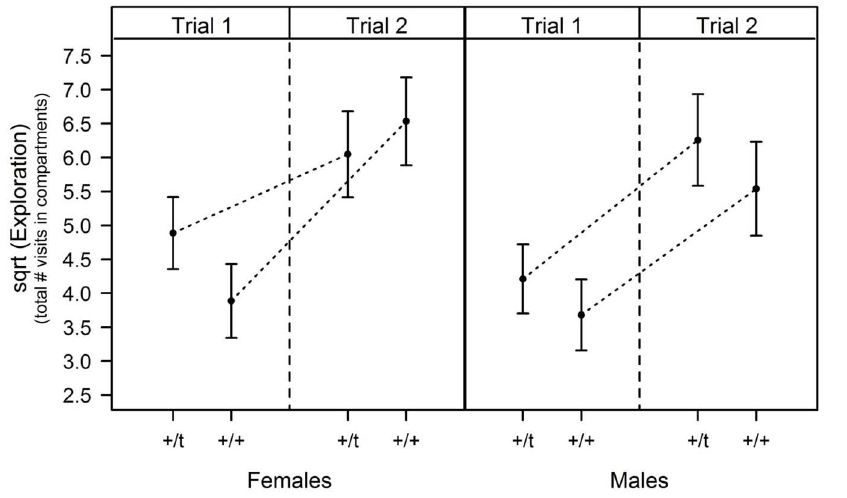
Figure 3. Effect of genetic background and sex on the propensity to form an exploratory routine: increase in exploratory behaviour (total number of visits to all compartments of the exploration apparatus) between the two trials (mean ± standard errors predicted by mixed effect model).